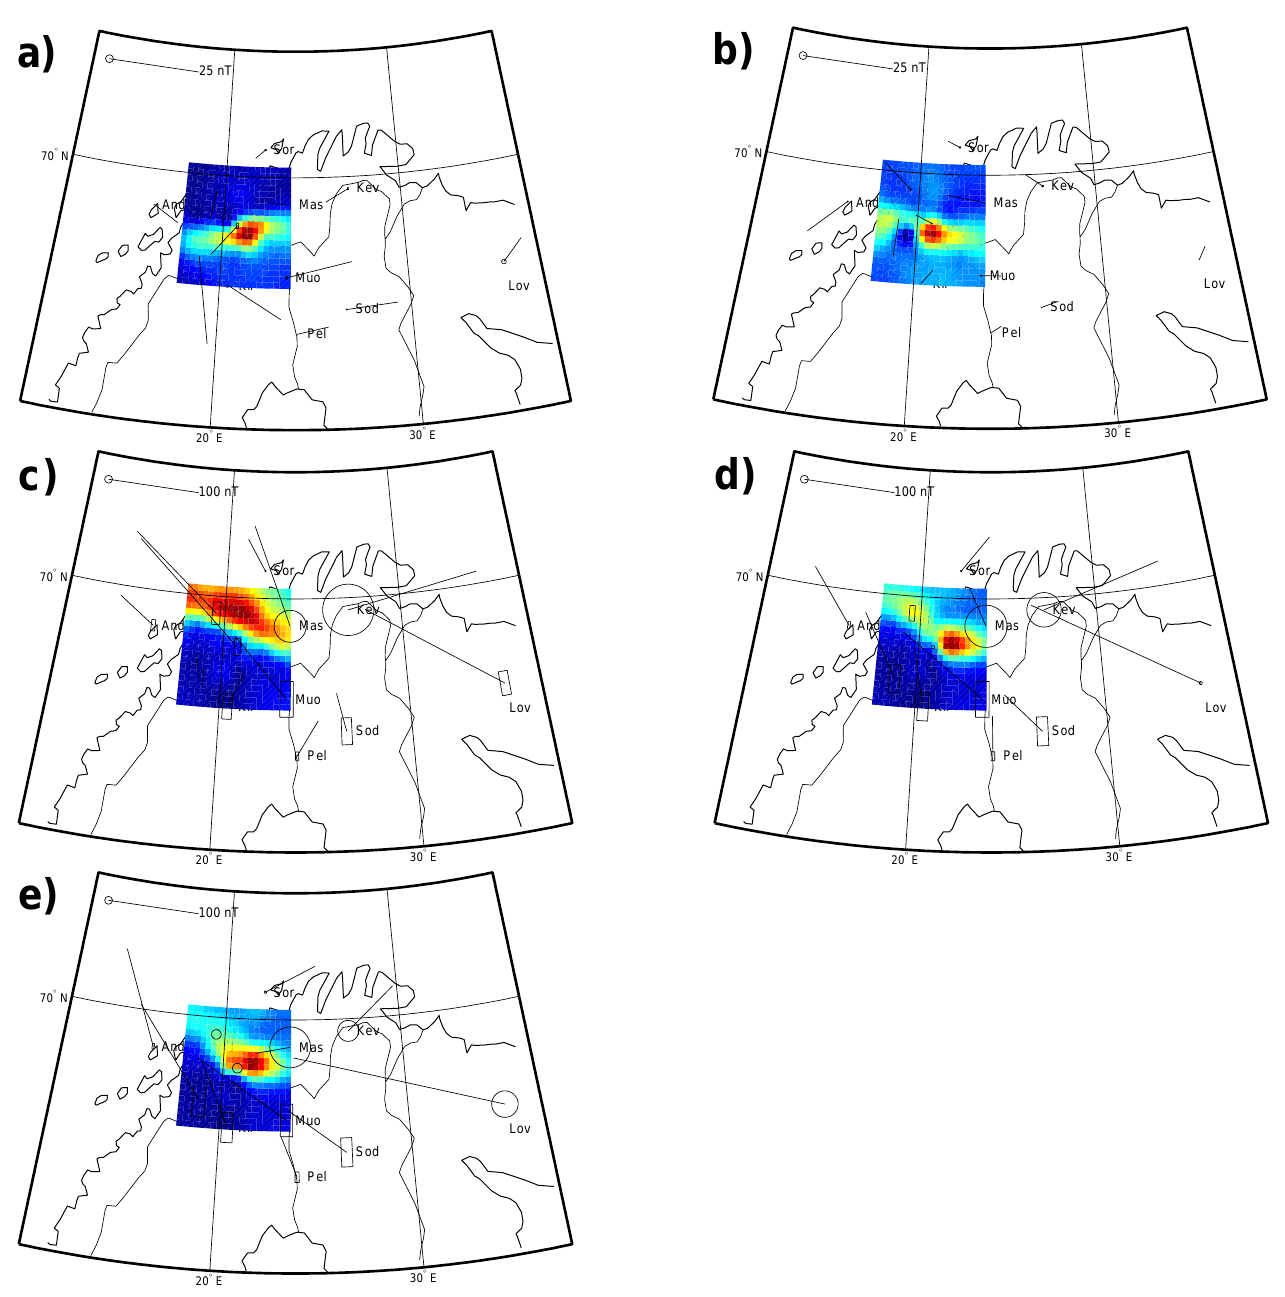
Fig. 2. Two-dimensional map of observations from the IMAGE network and the imaging riometer IRIS at Kilpisj¨arvi, Finland on 5 October 1999 from (a) 19:57:40 UT (b) 20:30:10 UT and (c-e) on 25 October 1999 from 17:10:50 to 17:11:10 UT with 10 second resolution. As a reference, a geographic grid, coastlines, and national borderlines are underlayed. The differential equivalent current (DEC) vectors with 1 t = 30 seconds show a counterclockwise and vortex-like pattern close by the region of an absorption spot near Kilpisj¨arvi. The vertical magnetic components, b z , are represented by rectacular boxes and circles, whereas boxes are negative and circles are positive.